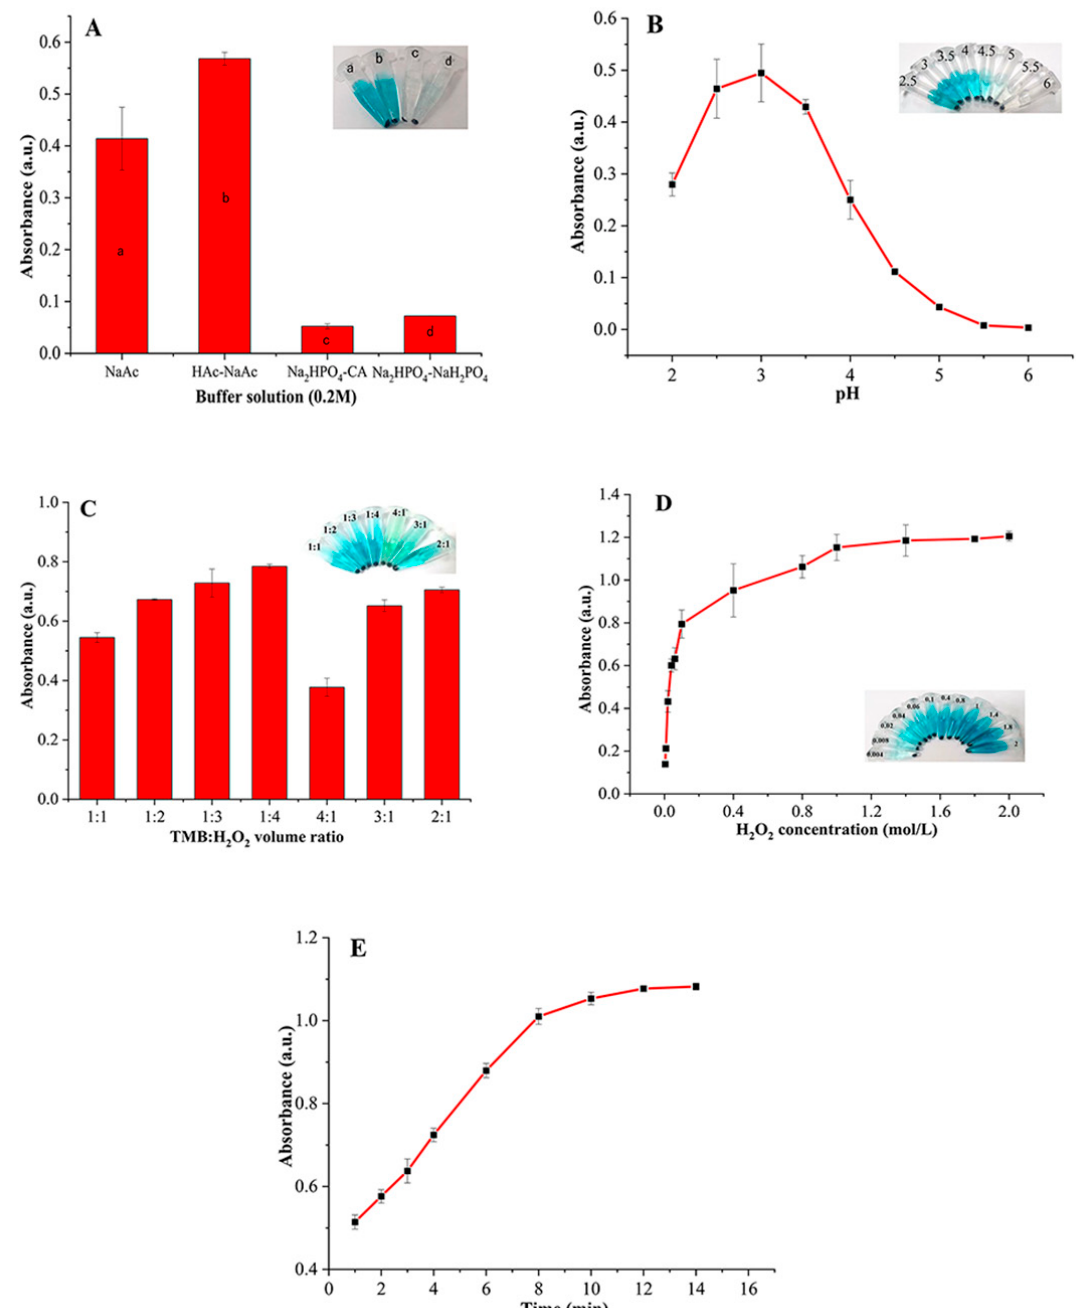
Figure 2. The influences of different factors on the performances of Fe 3 O 4 MMIP NPs. ( A ) Buffer type, 0.2 M buffer pH = 3.5, 250 μ L 0.06 M H 2 O 2 , 50 μ L 0.008 M TMB, reaction time 4 min; ( B ) pH, 0.2 M HAc-NaAc, 250 μ L 0.06 M H 2 O 2 , 50 μ L 0.008 M TMB, reaction time 4 min; ( C ) TMB/H 2 O 2 volume ratio, 0.2 M HAc-NaAc pH = 3.5, 0.06 M H 2 O 2 , 0.008 M TMB, reaction time 4 min; ( D ) H 2 O 2 concentration, 0.2 M HAc-NaAc pH = 3.5, 250 μ L H 2 O 2 , 50 μ L 0.008 M TMB, reaction time 4 min; ( E ) Reaction time, 0.2 M HAc-NaAc pH = 3.5, 250 μ L 0.06 M H 2 O 2 , 50 μ L 0.008 M TMB. All trials were repeated 3 times.